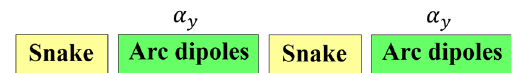
Fig. 9 Schematic of an ST super-period with a pair of identical snakes